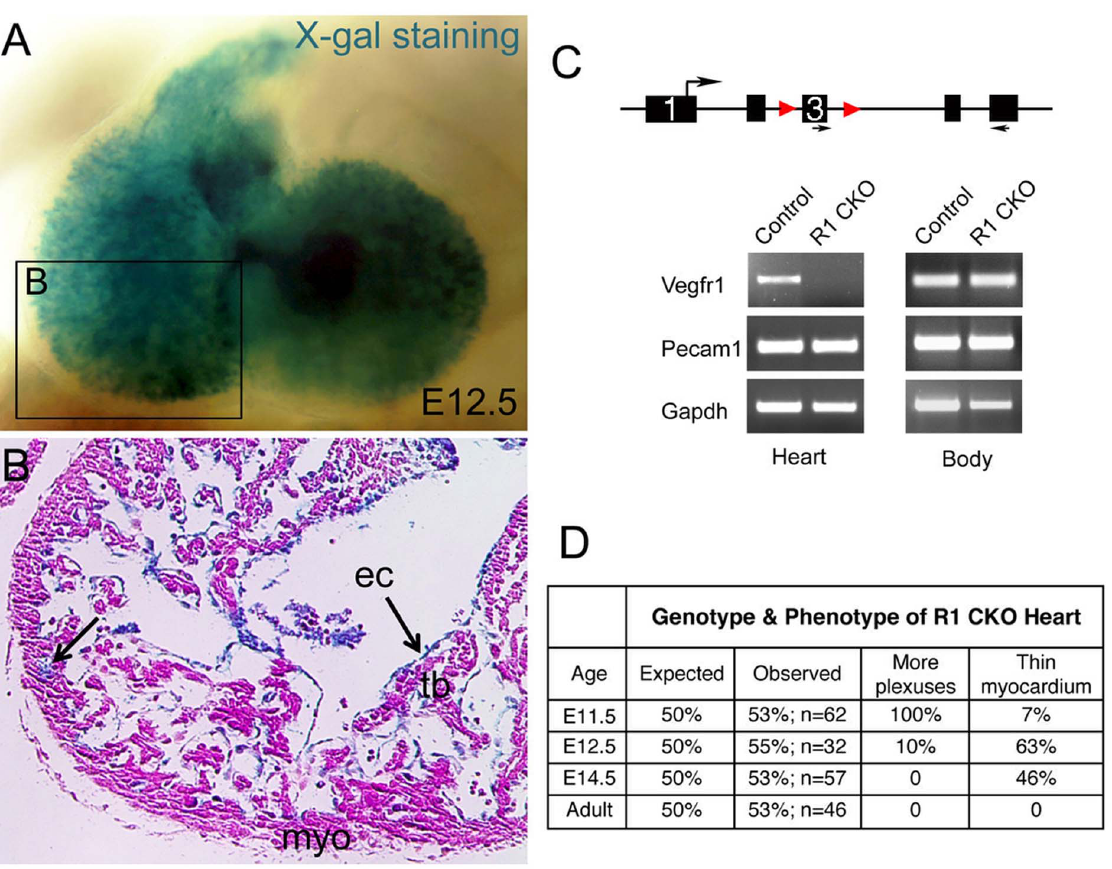
Figure 1. Tissue-specific knockout of Vegfr1 in the endocardium by the Nfatc1 Cre line. A, Wholemount X-gal staining of R26 fslz ;Nfatc1 Cre E12.5 embryo showing the Cre-activated lacZ expression within the heart. B, A frontal sectional view of the cardiac chamber demonstrating lacZ expression in the endocardium (ec; arrows), but not in the compact myocardium (myo) or trabeculae (tb). C, Depicting the endocardial-specific deletion of Vegfr1 in the embryos by the Nfatc1 Cre with RT-PCR analysis. D, A table summarizing the phenotypes of R1 CKO heart. An expected frequency (50%) of R1 CKO mice was found at different developmental stages and in adulthood, indicating that endocardial Vegfr1 was not required for survival. However, we observed a complete penetrance of early coronary plexus defect at E11.5, which only remained in a small subset of embryos at E12.5 and was not seen after E14.5. Additionally, half of E12.5 and E14.5 R1 CKO embryos had thin myocardium. The coronary phenotype was determined by immunohistochemistry, whereas the myocardial phenotype was determined by